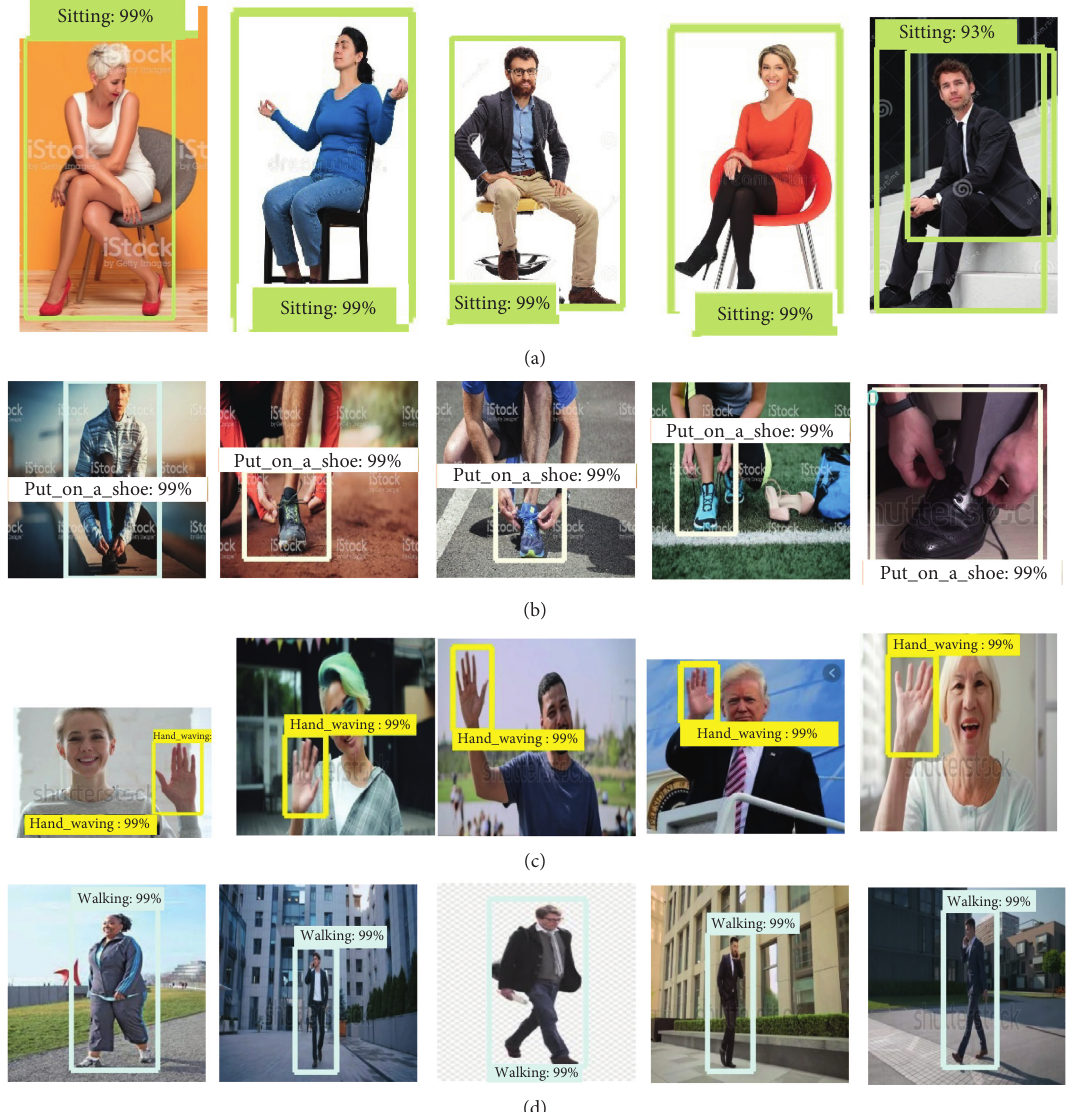
Figure 16: Training results with Tensorflow (RCNN +InceptionV2) for (a) sitting down, (b) wearing shoes, (c) waving hands, and (d)